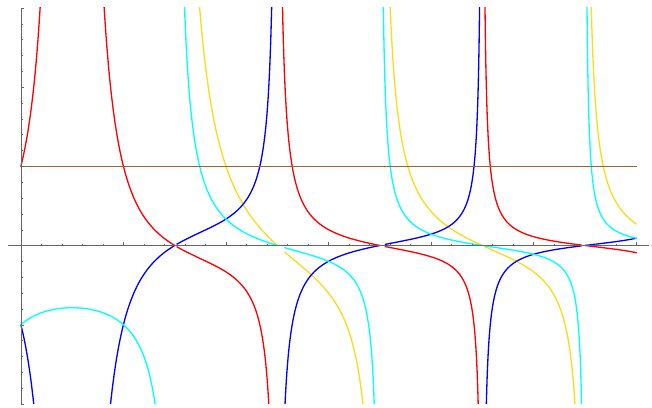
Figure 11 . The eigenvalues of the kernels of the 4-point functions in the model (5.1). The red and yellow curves are the eigenvalues of the symmetric and antisymmetric eigenfunctions of the kernel of the tensor 4 point function. The blue and cyan curves correspond to the symmetric and antisymmetric eigenvalues of the vector